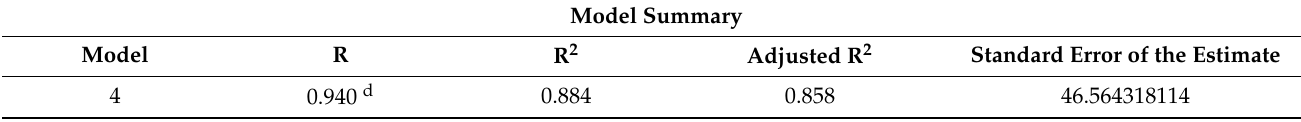
Table 8. Summary of the model for regions with direct management. Dependent variable: expenditure per